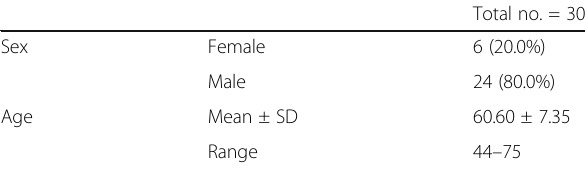
Table 1 Statistical data analysis including sex and age